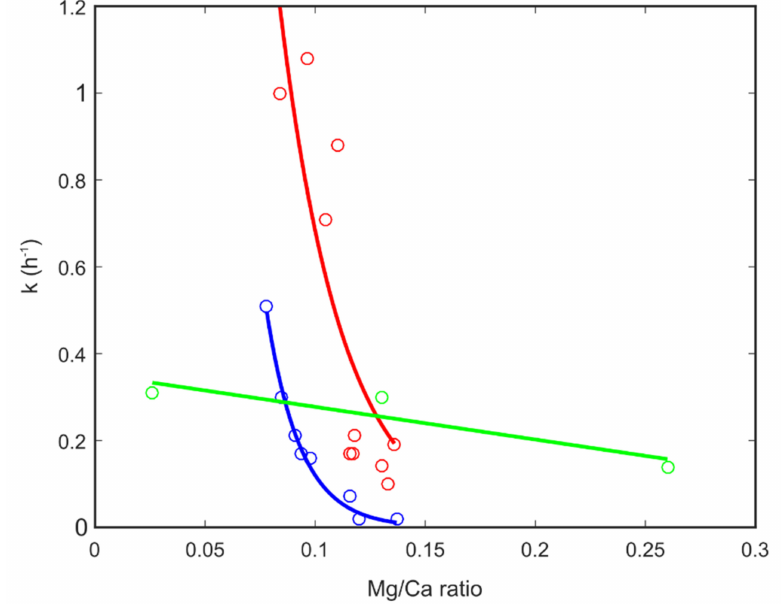
Figure 5. Reaction rates for the formation of initial ACC particles (green symbols and line) and subsequent formation of aragonite crystals (red symbols and line for formation in H 2 O and blue symbols and lines formation in D 2 O). The red and blue lines are exponential fits to the corresponding symbols, their equations are y = 22.87 e − 35.11 x for the red line and y = 76.38 e − 64.57 x for the blue line. The green line is a linear fit to the corresponding symbols giving: y = − 0.75 x +